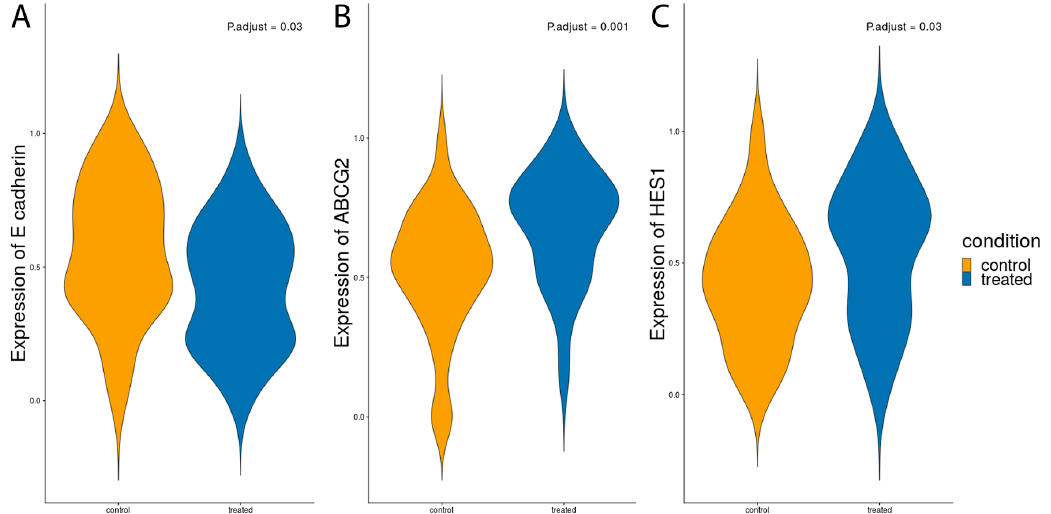
Figure 8. Transcriptional analysis of MCF7 CoCl 2 treated and untreated SP cells. Violin Plots were used to represent expression levels of mRNA for E-cadherin ( A ) ABCG2 ( B ) and HES1 ( C ). Note decreased expression of E-cadherin in the treated cells but an upregulation of ABCG2 and HES1 following treatment with CoCl 2.